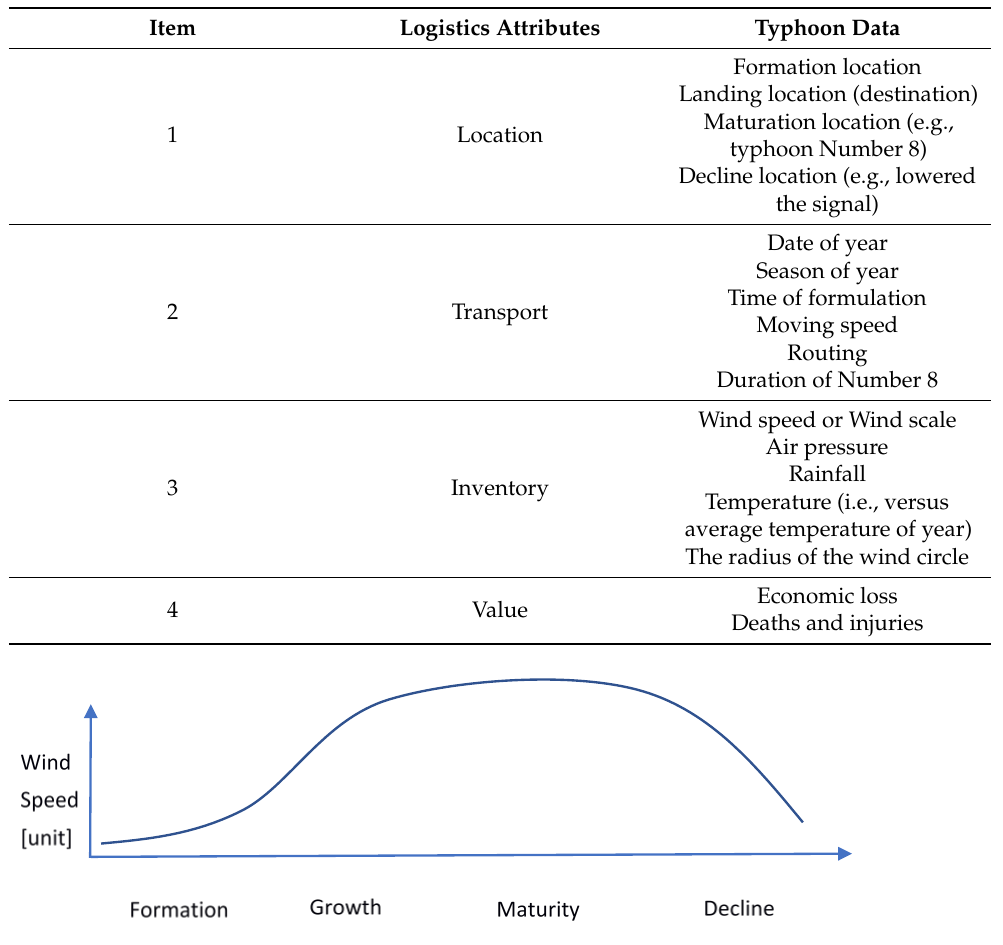
Table 1. Typhoon data as logistics attributes.